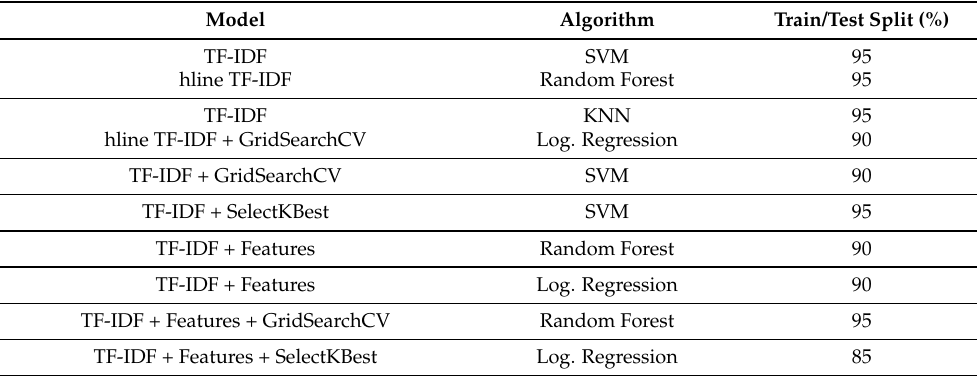
Table 5. Summary of best performing models and respective classification algorithms.